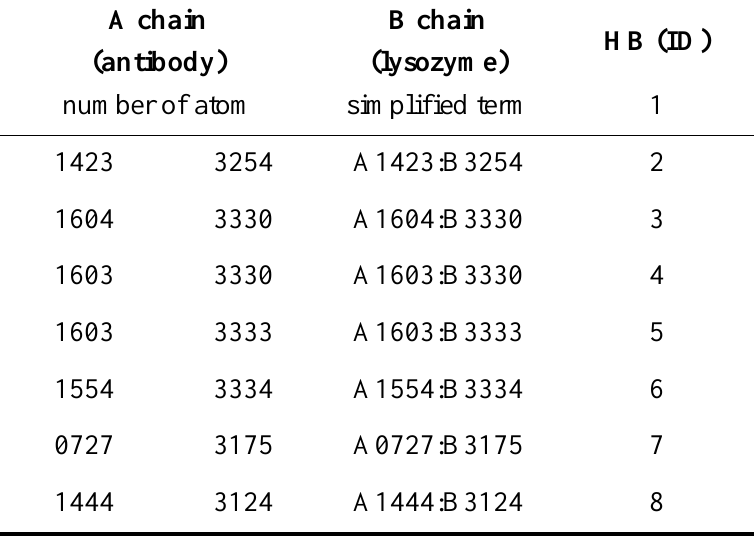
Table 2. The atoms of hydrogen bond formation.